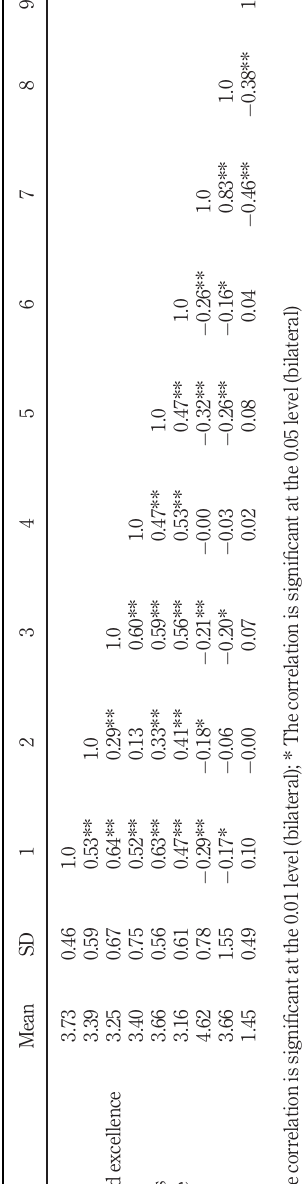
Table 3. Descriptive statistics and